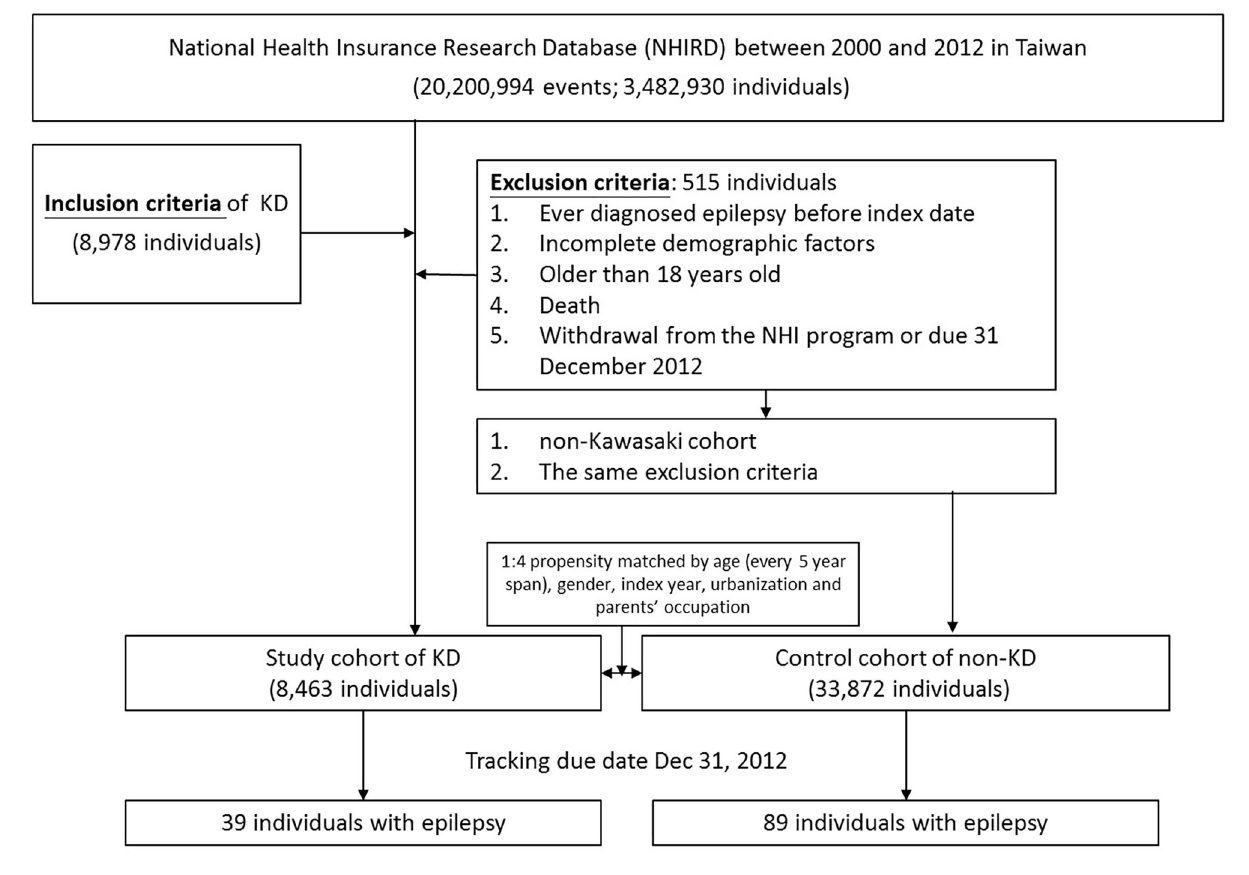
FIGURE 1 | The flowchart of study population